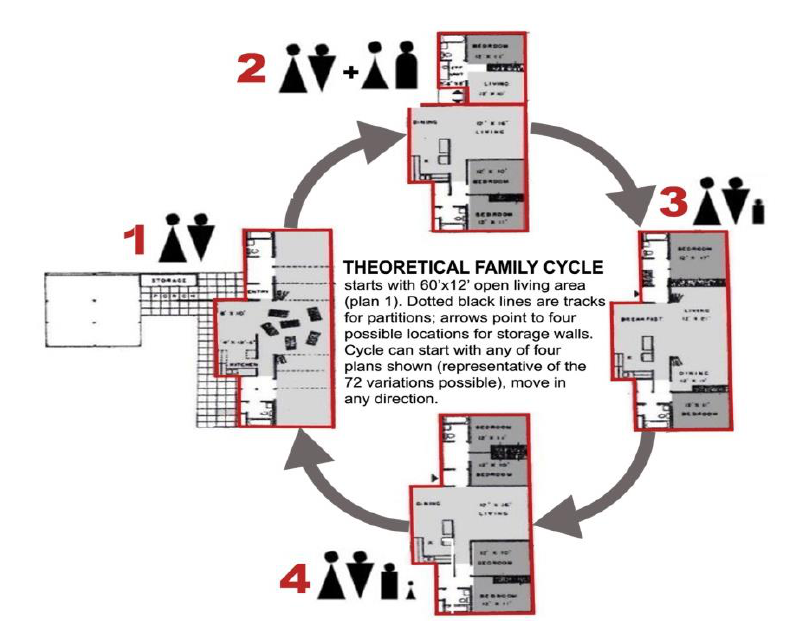
Figure 8 Modifying spatial order in a flexibly designed housing respecting the changes in the lifecycle, (Friedman, 2002, revised by authors